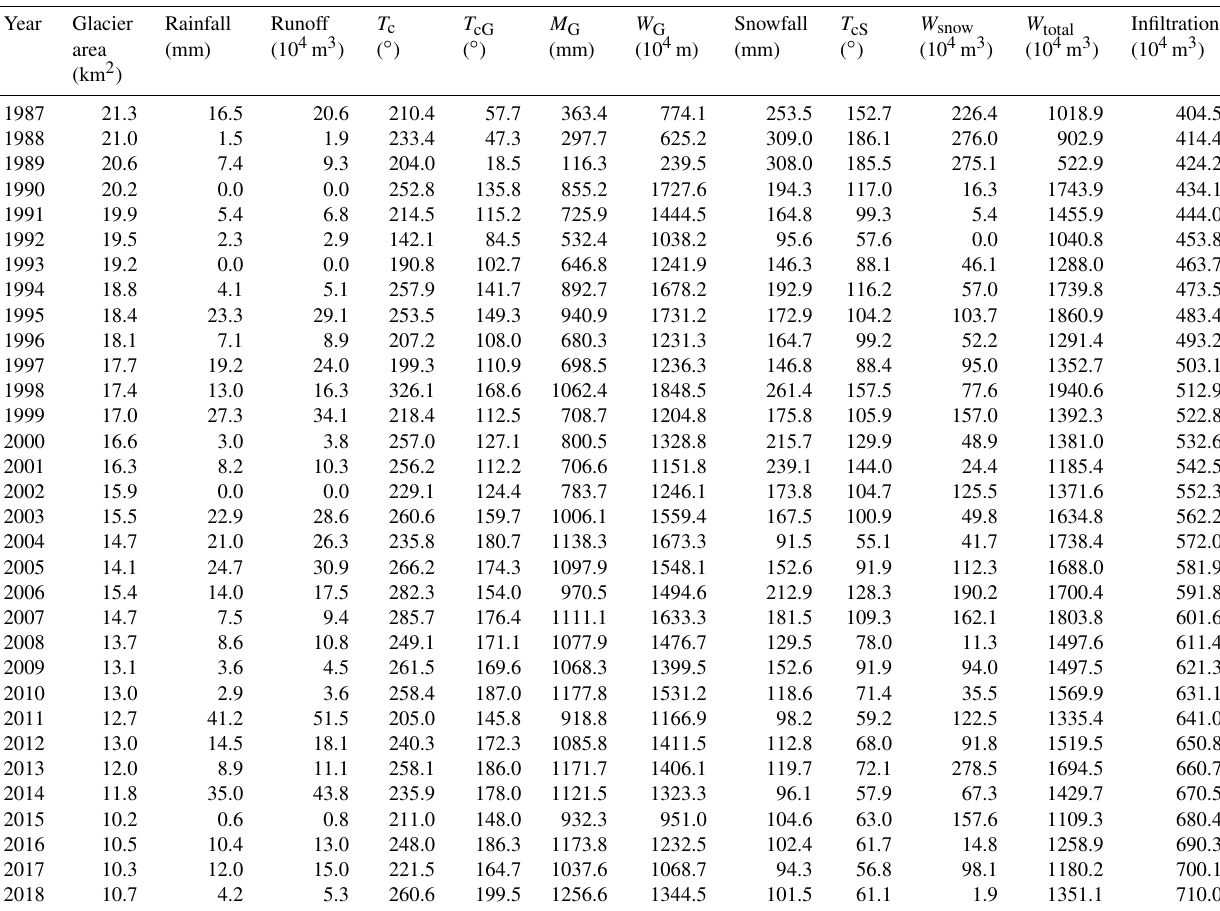
Table 11. Water balance for Galongco Lake between 1988 and 2018. Year